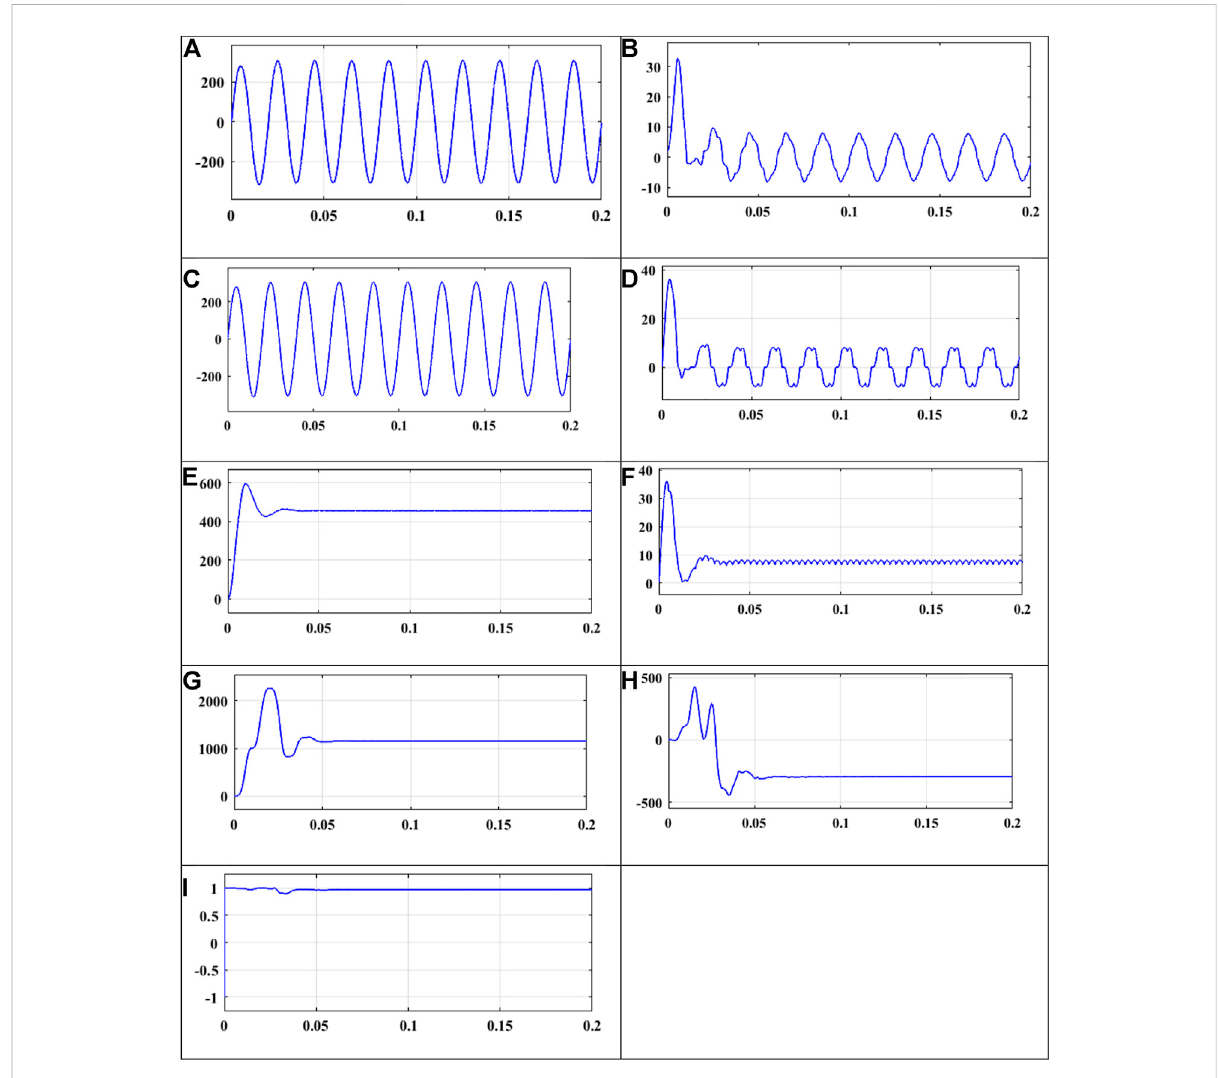
FIGURE 11 Voltage, current, and power waveform for a multiple-order harmonic fi lter. (A) Input voltage. (B) Input current. (C) Voltage at PCC. (D) Load current. (E) Voltage after recti fi er. (F) Current after recti fi er. (G) Real power. (H) Reactive power. (I) Power factor.